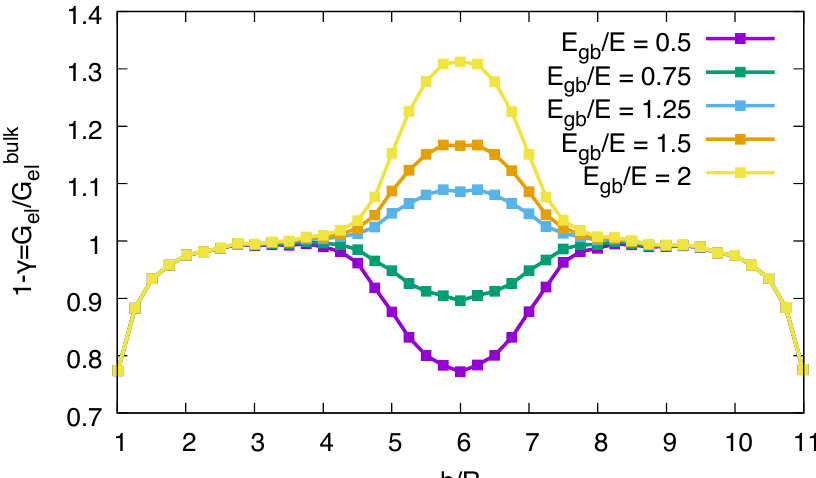
Figure 4. Elastic energy of the two-phase system with a precipitate near a free surface, in the bulk, or close to a hard or soft grain boundary. The energy is shown relative to the bulk energy